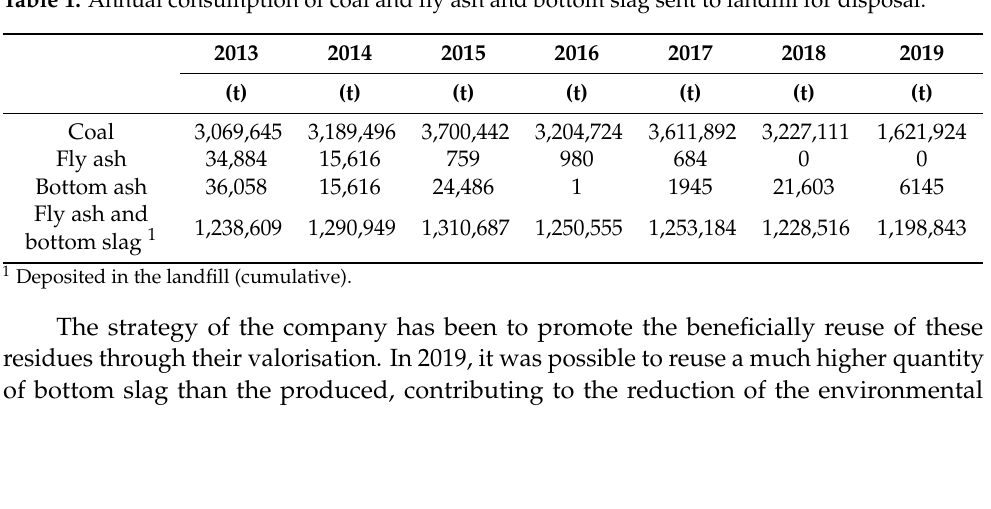
Table 1. Annual consumption of coal and fly ash and bottom slag sent to landfill for disposal.